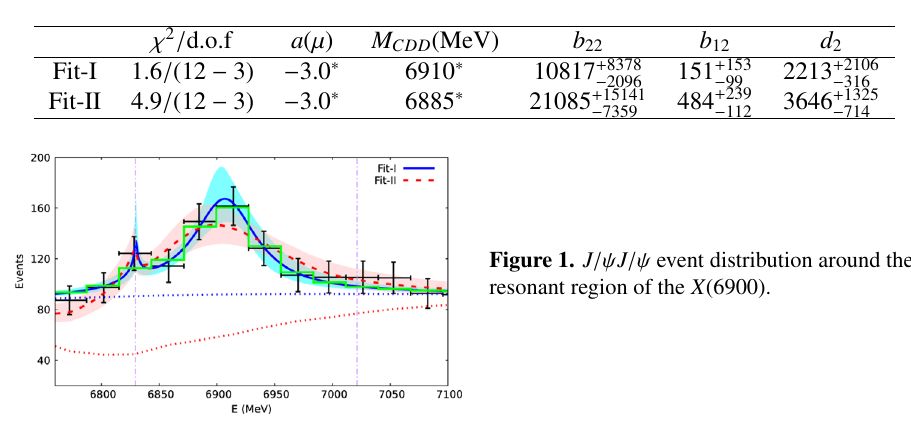
Table 4. Fits I and II. The entries marked with asterisks are fixed during the fits.